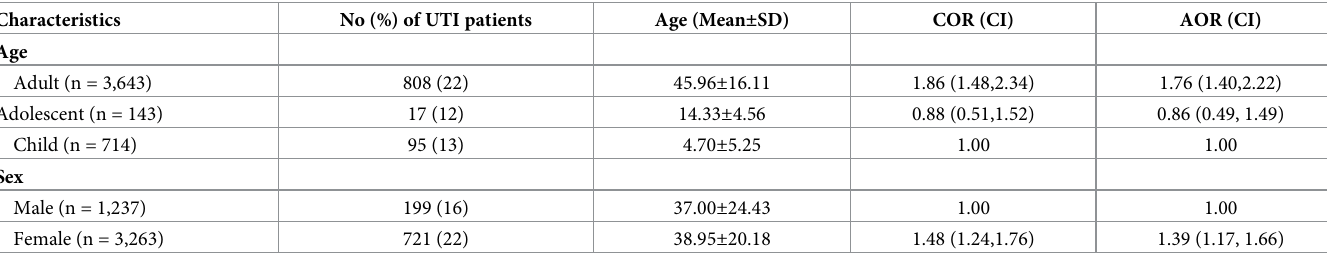
Table 2. Prevalence of community-acquired UTI among patients according to different age and sex groups.